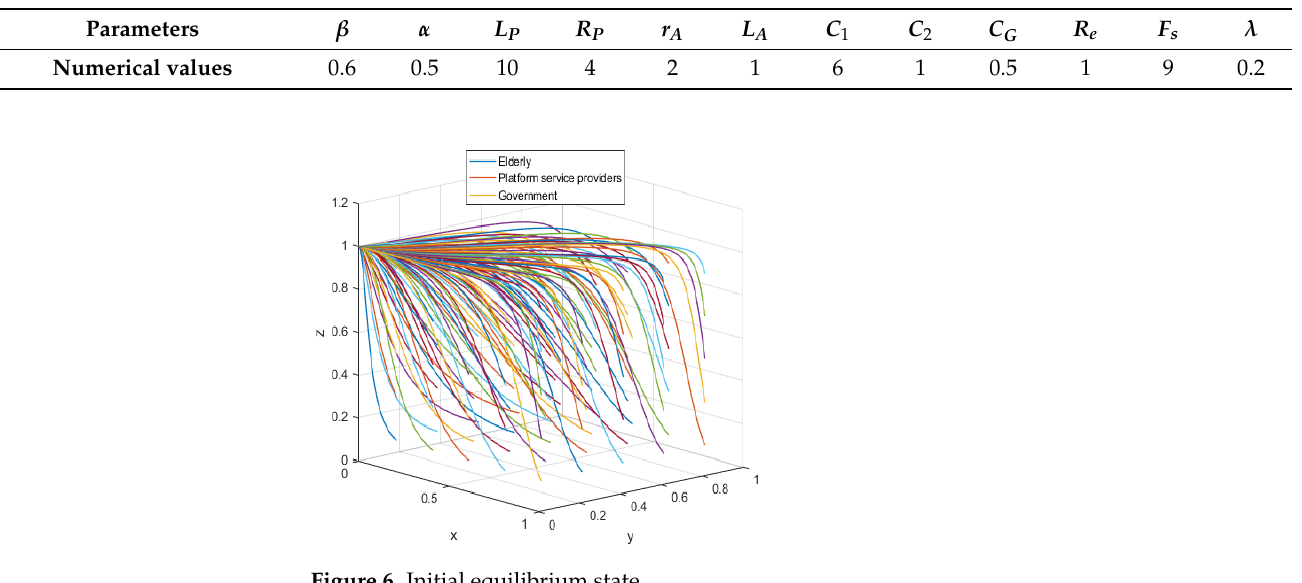
Figure 6. Initial equilibrium state.